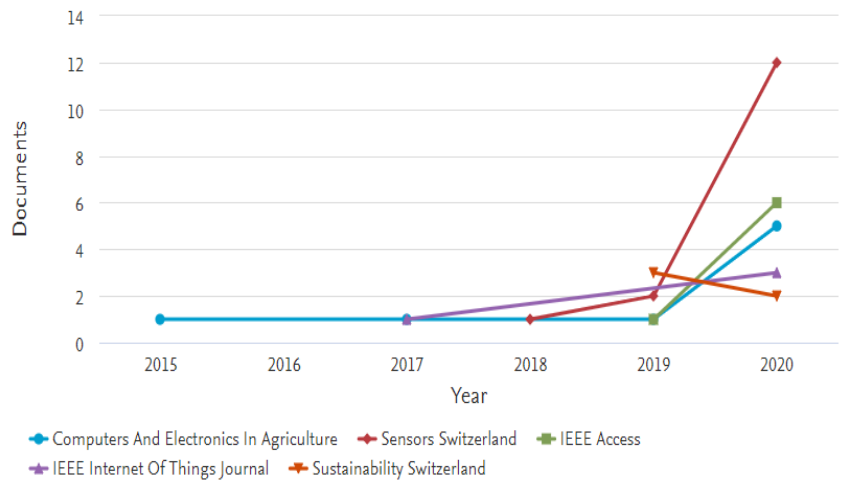
Figure 13. Top 5 source statistics for IoT in agriculture publications. Repository information